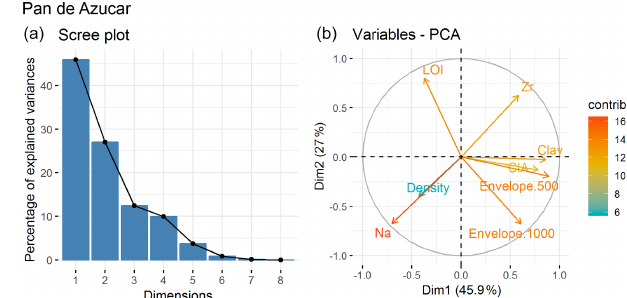
Figure 5. Principal component analysis (PCA) of properties for all four pedons in Pan de Azúcar. (a) Scree plot showing the percentage of explained variances and (b) variables –